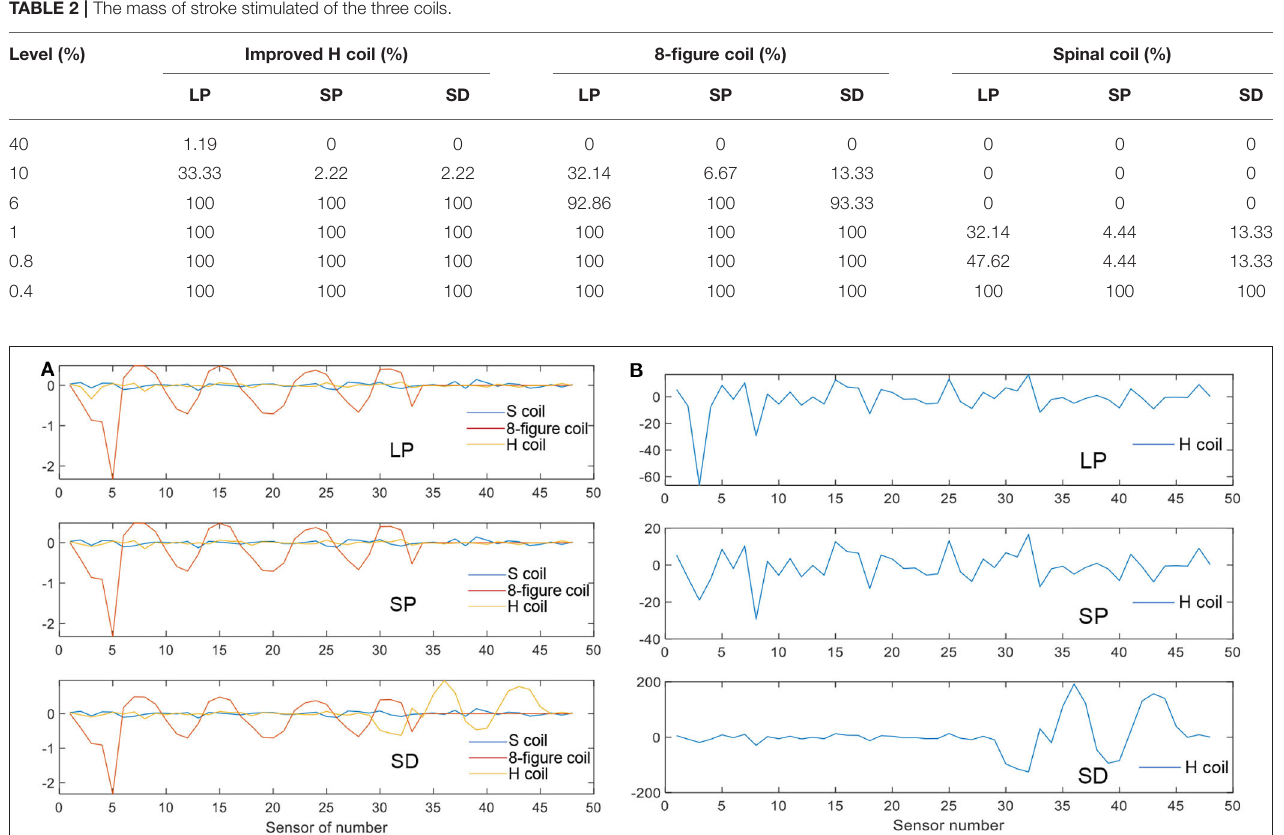
FIGURE 7 | MIT signal. (A) MIT Signals of the three coils for three strokes. (B) MIT signals of the H-coil for the three strokes.